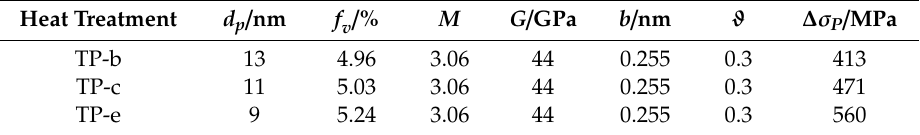
Table 5. Relevant parameters and calculated results of the precipitation